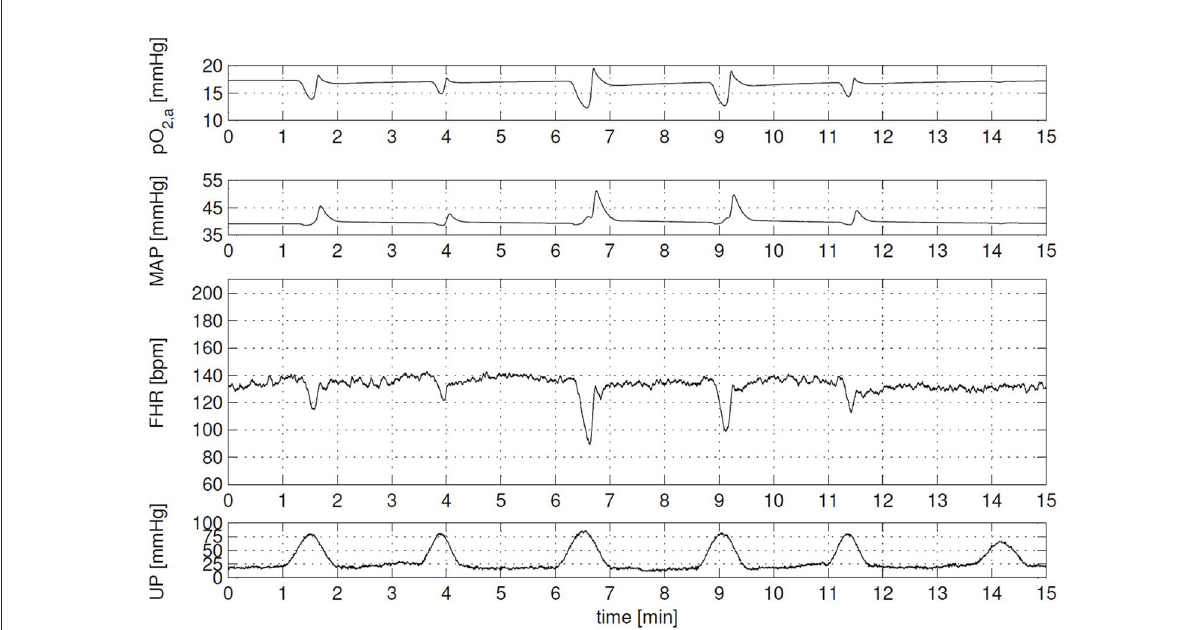
FIGURE3 Clinical scenario: cardiotocography (CTG) with variable decelerations and corresponding arterial oxygen ( pO 2, a ) and mean arterial pressure (MAP) signal. Each contraction evokes a different fetal heart rate (FHR) response, due to contraction-to-contraction changes in both uterine pressure level (UP) and duration, and in the compressibility of the umbilical cord. Overall, FHR corresponds well with changes in MAP and pO 2, a . This figure is obtained from the Ph.D. thesis of (73) with